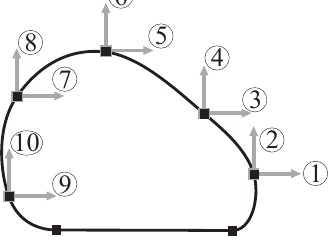
Fig. 10. Gravity dam. Design variables